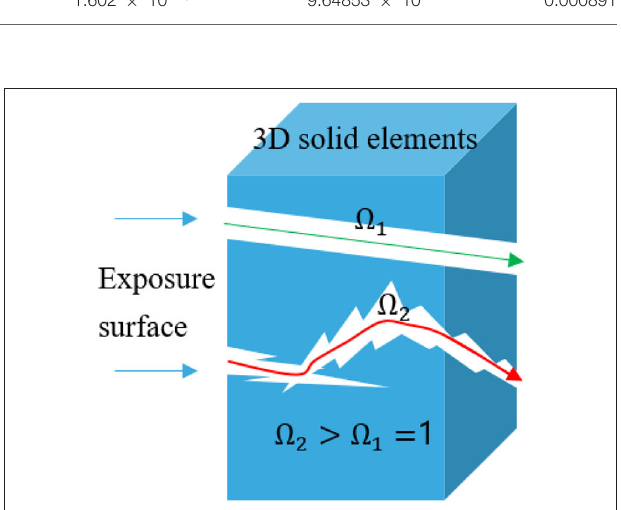
FIGURE 1 | Tortuosity of concrete solid